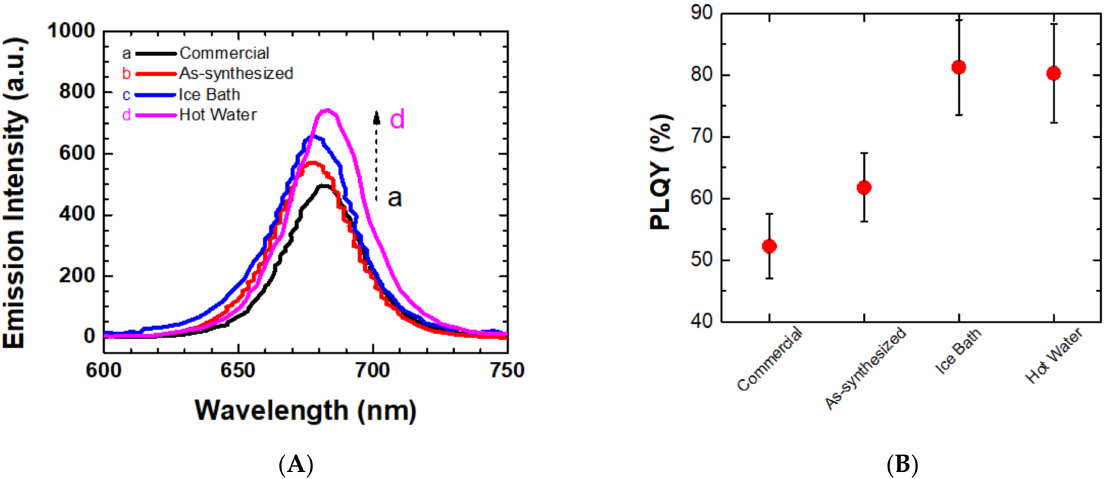
Figure 3. ( A ) Photoluminescence spectra of the four CsPbI 3 PQDs made using four different PbI 2 (a: Commercial, b: As-synthesized, c: Ice Bath, d: Hot Water PbI 2 ). Photoluminescence spectra were taken by fixing their band edge absorption as 0.1 ± 0.005. ( B ) PLQY of CsPbI 3 PQDs made using four different PbI 2